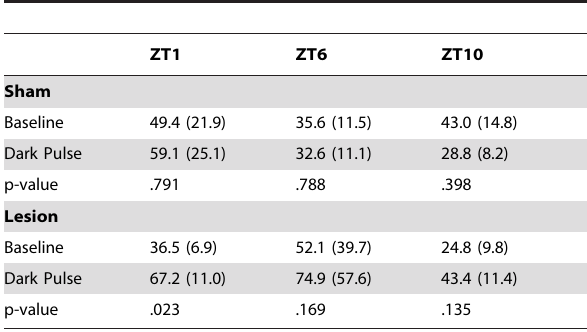
Table 2. Means (SE) for 1-h dark pulses presented at ZT1, ZT6, and ZT10 in shams and grass rats with IGL